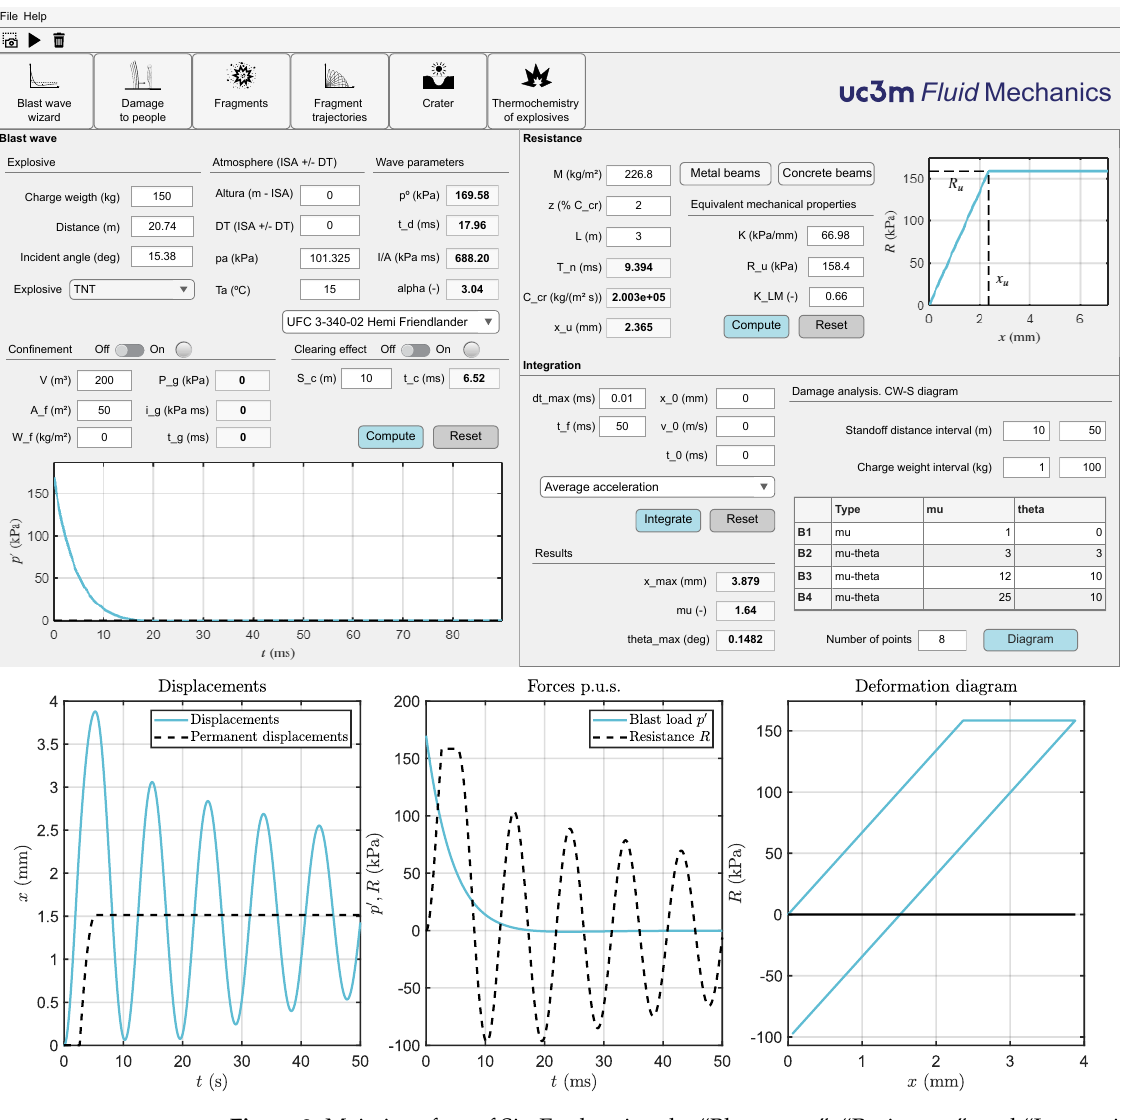
Figure 2. Main interface of SimEx showing the “Blast wave”, “Resistance”, and “Integration” assis- tants for the computation of the structural response of perfect elasto-plastic SDOF systems under blast loading. The access buttons to the other calculation assistants are seen under the top toolbar. The bottom plots show the post-processing pop-up window that displays the results of the numerical integration in terms of displacements, forces, and deformation diagrams (for a detailed discussion of these diagrams, see Section